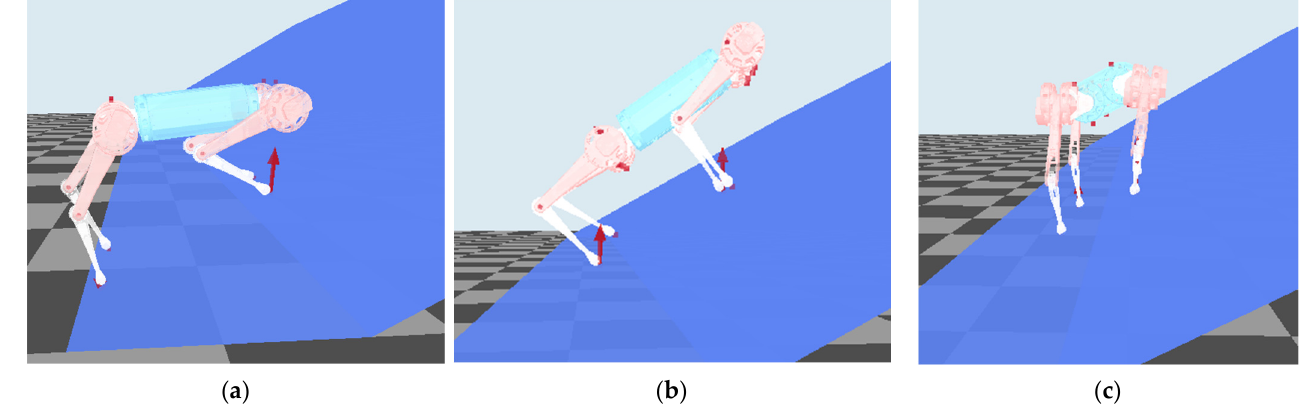
Figure 8. Comparison of the slope walking posture. ( a ) Before adjustment; ( b ) Forward walking after adjustment; ( c ) Lateral walking after adjustment.